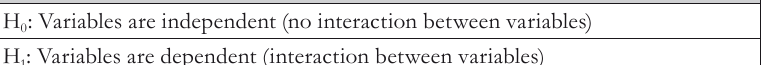
Tab. 10 – Q3a Chi-squared Test and p-value. Source: authors Pearson’s Chi-squared test with simulated p-value (based on 5000